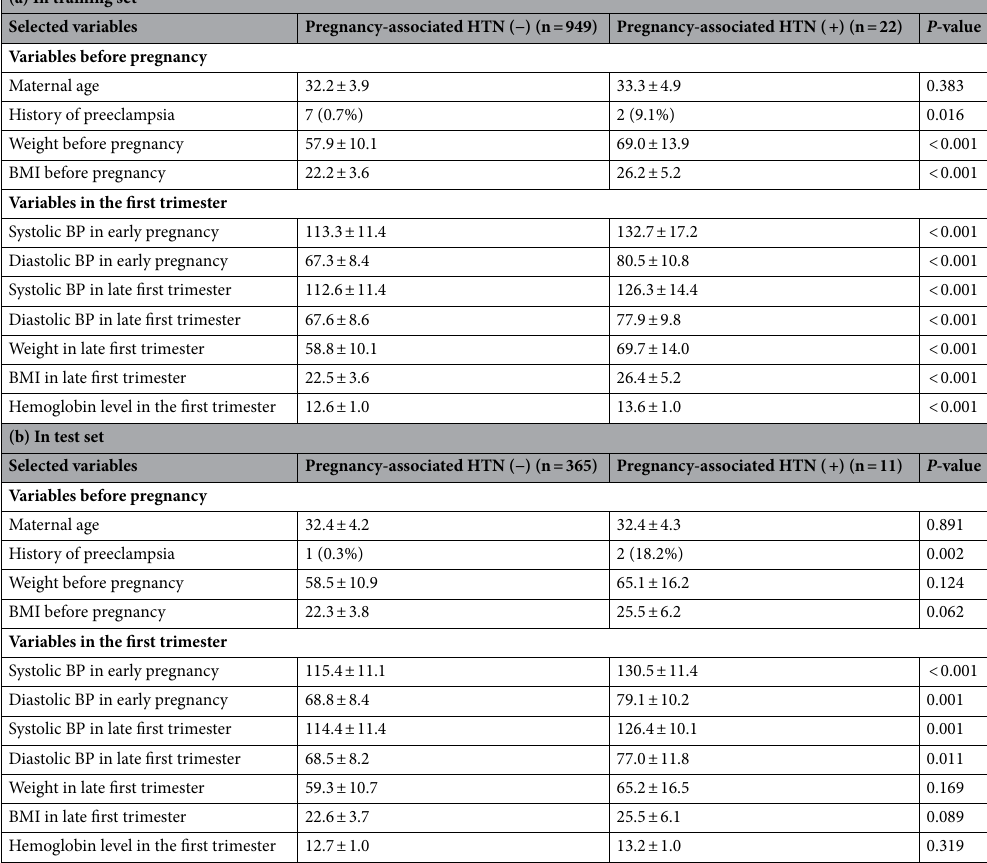
Table 3. Analysis of selected top 11 important variables in the study population. Early pregnancy, measured at 7.7 ± 1.2 weeks; late first trimester, measured at 12.4 ± 0.5 weeks. BMI body mass index, BP blood pressure.